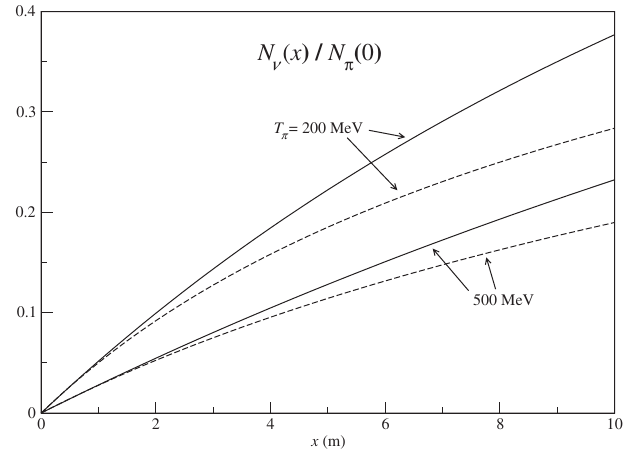
ð x Þ , normalized by the number of FIG. 1. Dependence of N (cid:1) ð 0 Þ , as a function of distance along the pion input pions, N (cid:3) accelerator, x , for two pion kinetic energies spanning the pro- duction peak at injection into the accelerator. The solid curves are for a gradient of 10 MeV = m , while the dashed curves are for 50 MeV = m